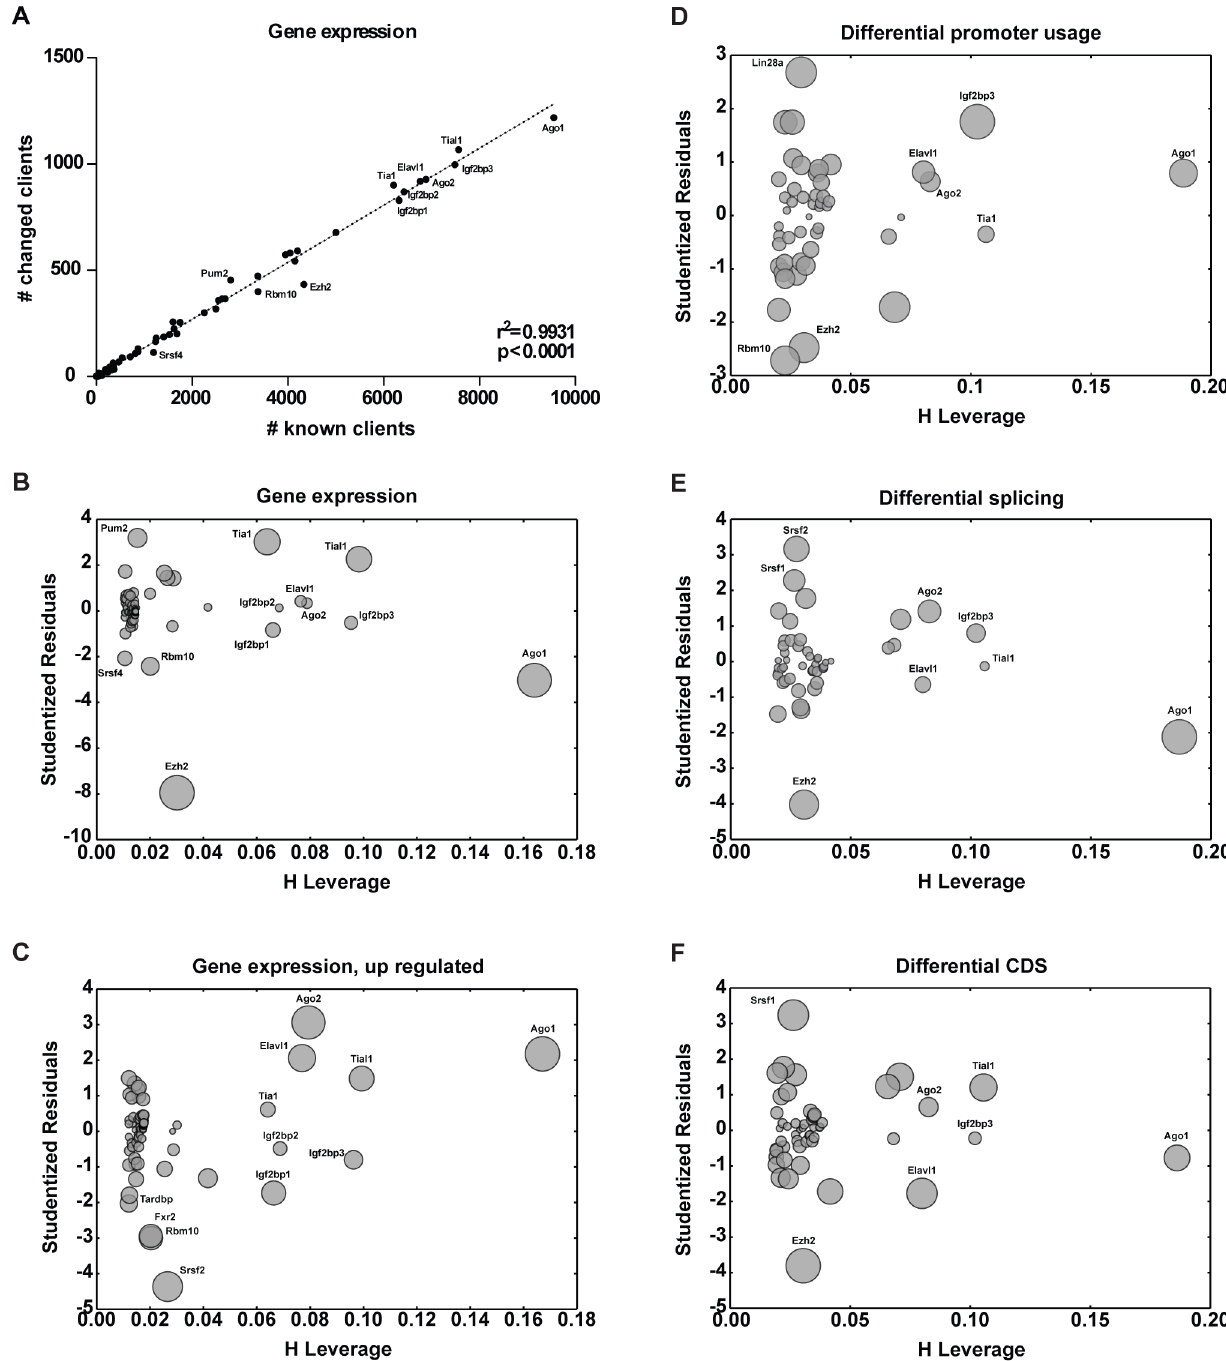
Fig 2. Inference of outlying RBP-client interactions from changes in client transcripts. (A) Using gene expression levels, numbers of altered client mRNAs were plotted against number of known client mRNAs for each respective RBP. A linear correlation could be identified between the number of changed client mRNAs and known client mRNAs. (B) Studentized residuals (outlyingness), leverage (potential to influence the linear model) and influence analysis (represented by the size to point) are represented through influence plots. Data points perturbing the model were identified by high leverage and studentized residuals. Outliers representing RBPs with higher number of changed client mRNAs were identified through high absolute values of standardized residuals. The same was done by (C) plotting number of upregulated clients against number of changed clients, as well as using vector information on (D) differential promoter usage, (E) differential splicing, and (F) differential CDS. DNA damage-related RBPs — Elavl1, Tia1, Tial1, Srsf1, Srsf2 could be identified through RBP-client analysis.